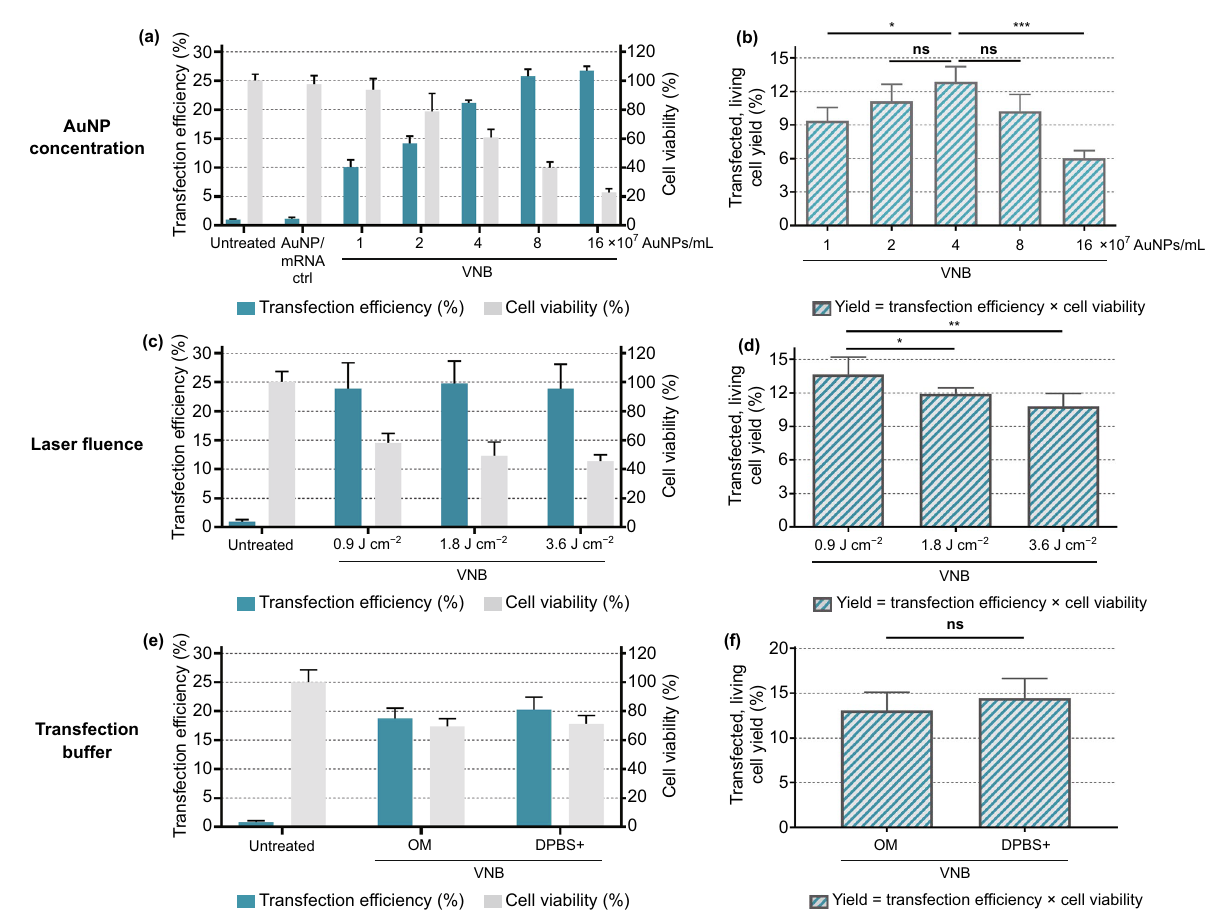
Fig. 5 Optimization of gold nanoparticle (AuNP) concentration, laser fluence and transfection buffer for eGFP-mRNA transfection in Jurkat cells. Transfection efficiencies represent the percentage of eGFP-positive cells, cell viability values were calculated relatively to the untreated control and yields are calculated as the product of transfection efficiency and cell viability. a, b Screening for AuNP concentrations, using a fixed laser fluence of 1.8 J cm − 2 ( n = 3, one-way ANOVA with Dunnett’s multiple comparison test, ns = nonsignificant; * p < .05, *** p < .001). c, d Screening for laser fluences (in J cm − 2 ), using a fixed AuNP concentration of 4 × 10 7 AuNPs mL −1 ( n = 3, one-way ANOVA with Dunnett’s multiple comparison test, ns = nonsignificant; * p < .05, ** p < .01). e, f Comparison of Opti-MEM (OM) and DPBS + as transfection buffer, using a fixed AuNP concentration of 4 × 10 7 AuNPs mL −1 and laser fluence of 0.9 J cm −2 ( n = 3, unpaired Student’s T test, ns =